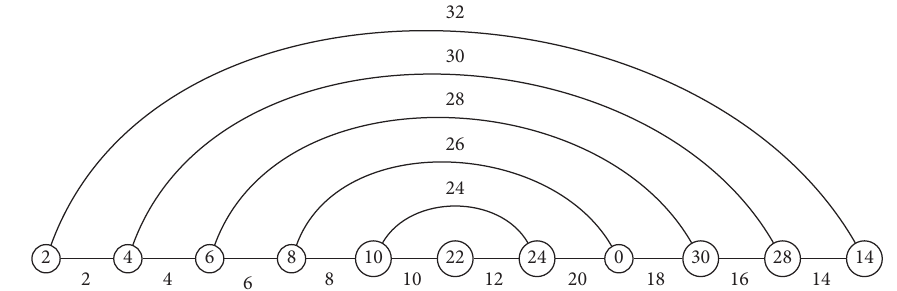
Figure 15: The tortoise graph T